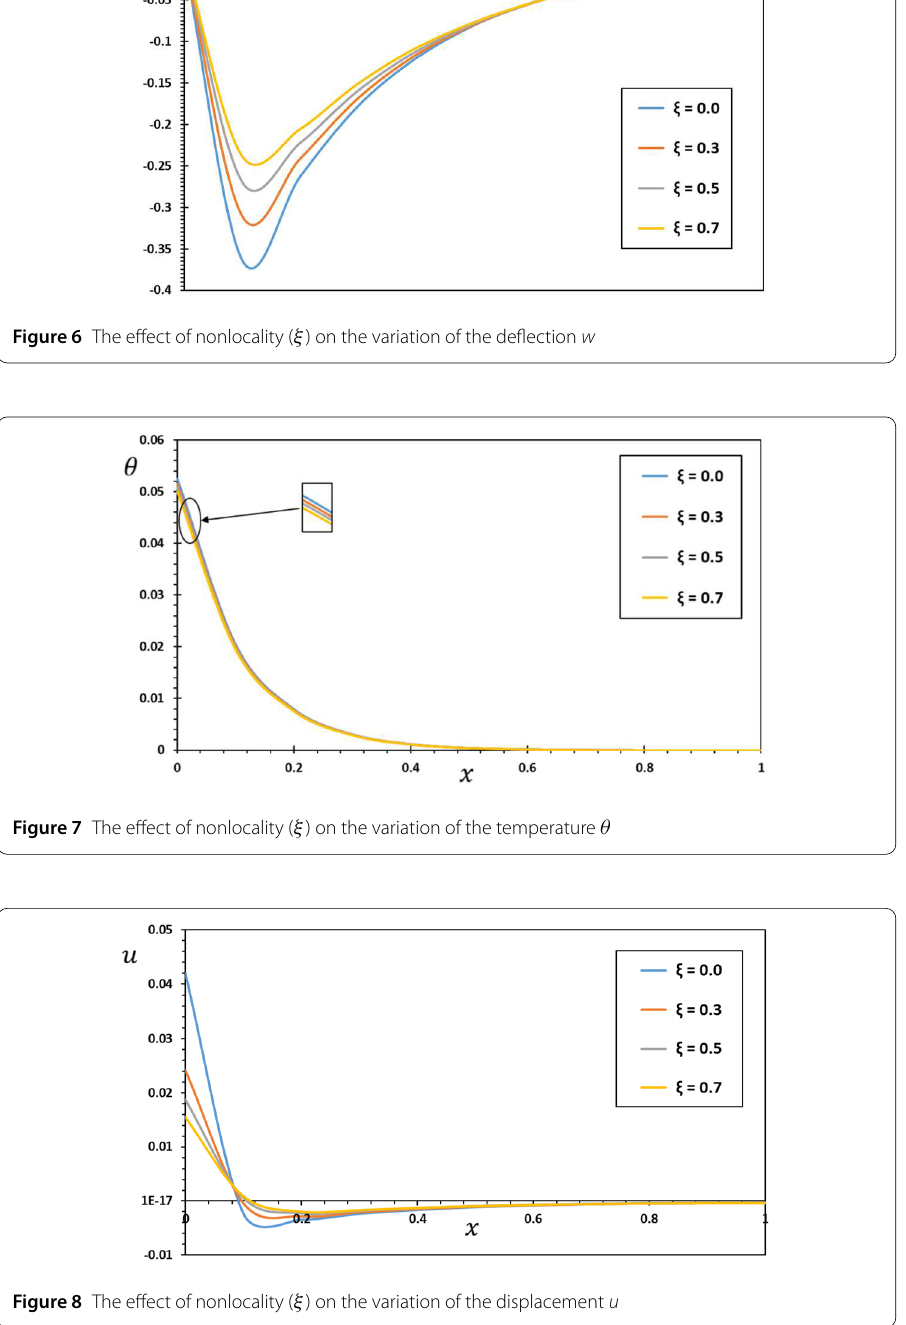
[55]. Other aspects for media with microstructure can be found in [56–61]. It can be con- cluded further that the steady state of the mechanical waves within the beam depends on specific values of the nonlocal index ξ